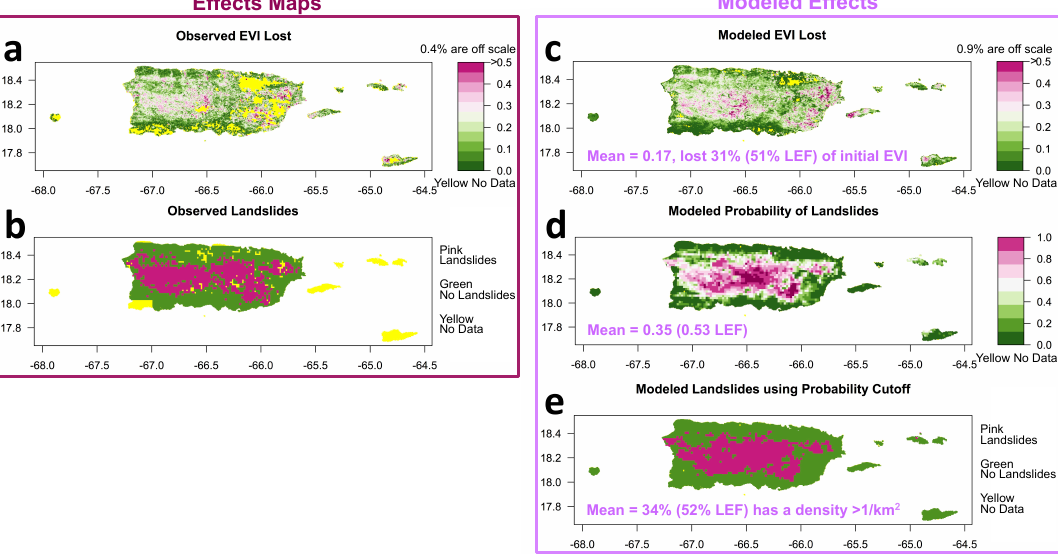
Figure 1. Observed hurricane effects and modeled effects over Puerto Rico and the U.S. Virgin Islands. Observations (plots a , b ) are from remote sensing and were used as dependent variables in generalized linear models. Modeled effects plots ( c – e ) list mean regional values for later comparison along with the Luquillo Experimental Forest (LEF) means. The cutoff probability of landslide occurring was set at 0.53 (plot d to e